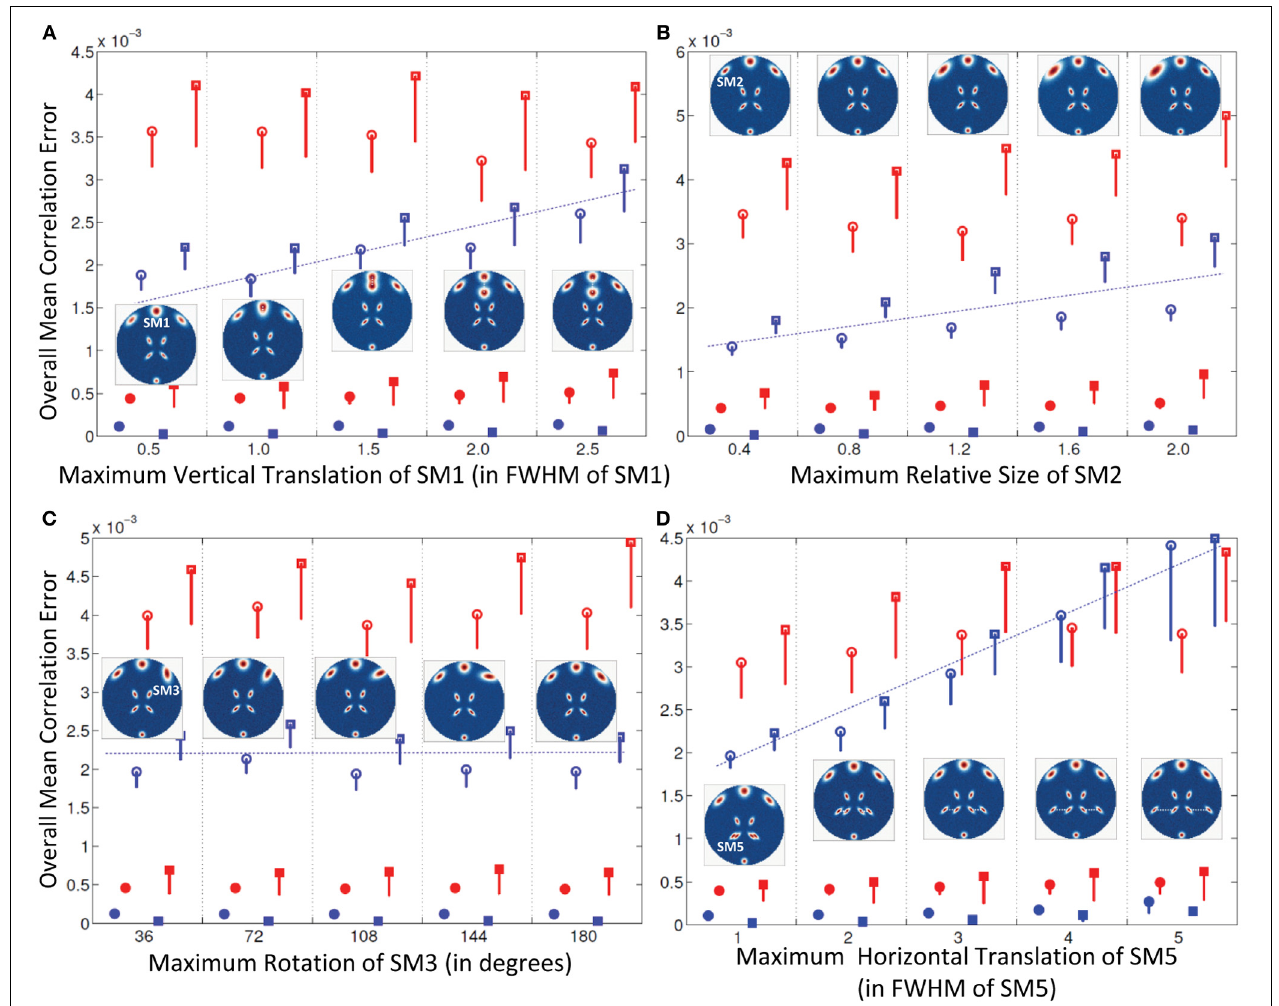
FIGURE 3 | Results of Experiment 2: Estimation accuracy when one spatial map (SM) is varied in subjects. Errors reported here are the overall mean correlation errors (across all components and subjects); see “Definition of Result Evaluation Parameters” section for definitions. Mean errors are in blue for GICA and in red for IVA. Diagonal elements of the correlation error matrix are in filled shapes and non-diagonal elements in unfilled shapes. SMs are presented in circles and TCs in squares. X -axis represents the maximum level of a single SM’s variability between